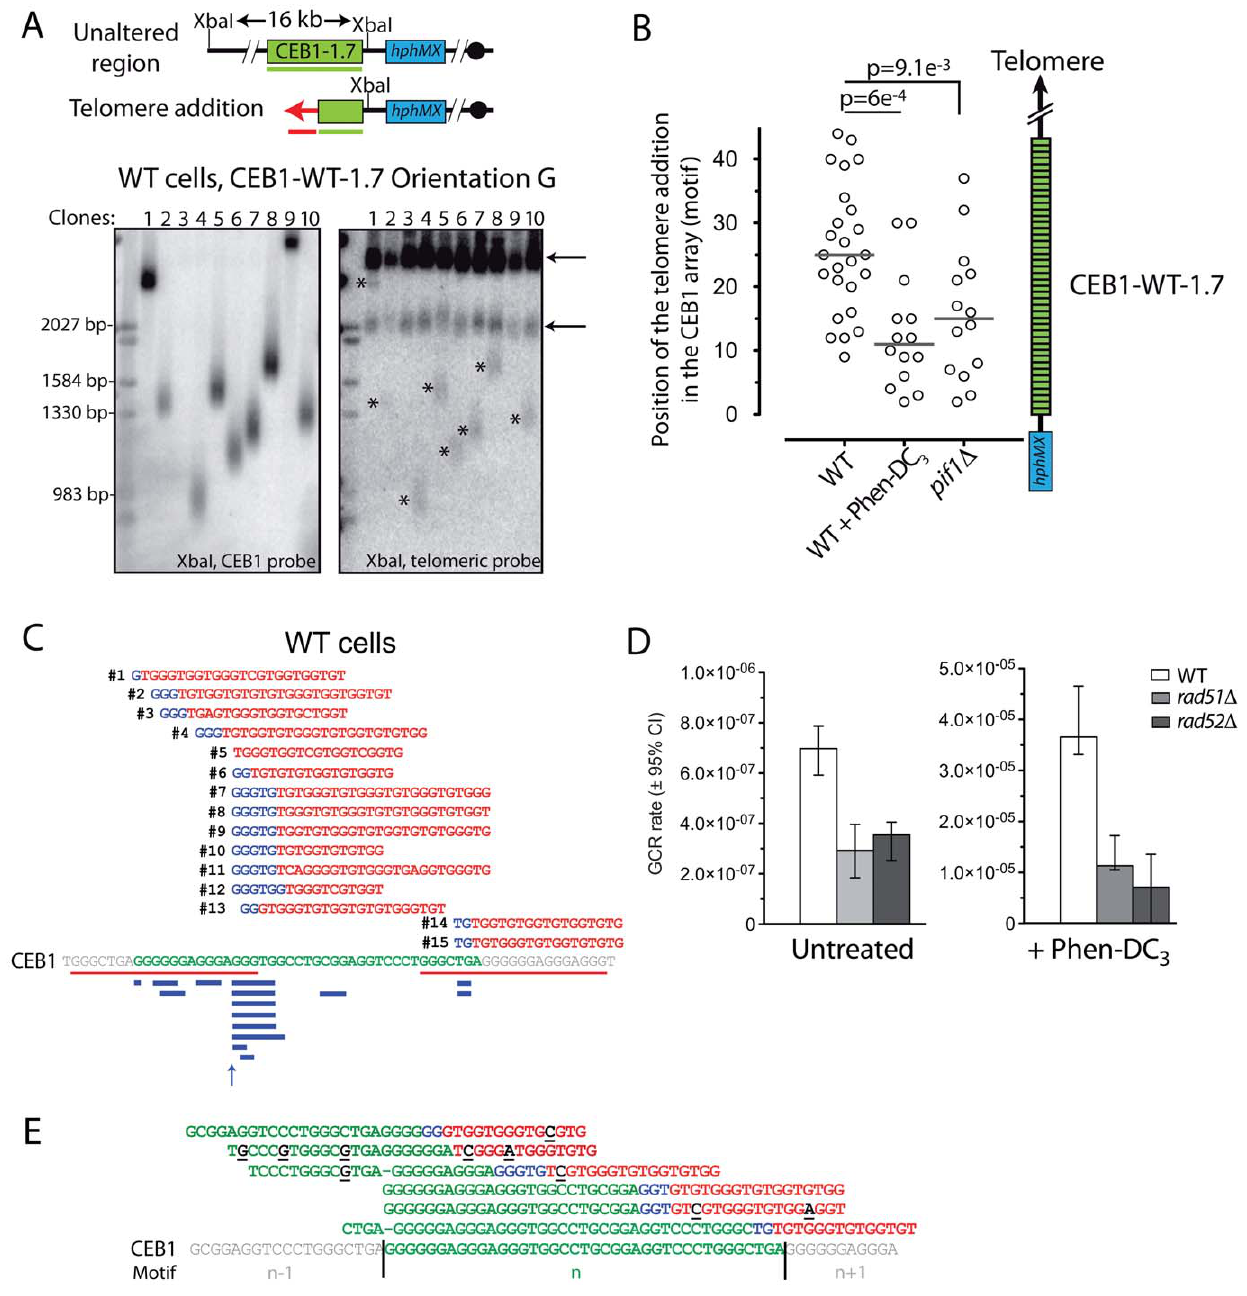
Figure 3. GCR are mainly telomere additions in CEB1. (A) The top panel schematically represents the genomic region surrounding CEB1 with the XbaI restriction site and the CEB1 (green) and TG 1–3 (red) probes used to study rearrangements of the region. The size of the unaltered region upon digestion is indicated. Upon telomere addition, digestion with XbaI is expected to produce a fragment that can be hybridized by both the CEB1 and the telomeric (TG 1–3 ) probe. The bottom panels show the rearrangements present in independent 5FOA/Can-resistant colonies obtained from WT cells bearing CEB1-WT-1.7 in the orientation G (ORT6542-6). Stars indicate smears hybridizing both the CEB1 and the telomeric probes (Orientation G lanes 1,2,4,5,6,7,8,10). Arrows indicate endogenous telomeres. Ambiguities remained for CEB1 smears co-migrating with endogenous telomeres (clone 9). One lane shows no CEB1 signal (clone 3). (B) Distribution of the telomere addition positions within CEB1-WT-1.7 estimated from the mean molecular weight determined by Southern blot (see Materials and Methods) in untreated and Phen-DC 3 -treated WT cells (ORT6542-6), and pif1 D cells (ORT6543-1). Grey bars show the median of the distributions. Distributions were compared using a non-parametric test (Mann-Whitney- Wilcoxon). (C) Analysis of the CEB1-telomere junctions in WT cells (ORT6542-6). Each CEB1-telomere junctions have been obtained from 15 independent 5FOA/Can-resistant colonies. The sequences are oriented 5 9 -3 9 . The template CEB1 motif is shown in green, and the flanking motifs (n 2 1 and n + 1) are shown in grey. The G-quadruplex forming motifs are underlined in red. Nucleotides shared by both the CEB1 and the telomeric sequences at the junction are in blue. The telomeric sequence is in red. The CEB1 sequence above the junctions is identical to the CEB1 reference, and is not shown for each molecule. A schematic representation of the length of shared nucleotides between the CEB1 and the telomeric sequences is shown in blue below the reference CEB1 motif. An arrow indicates the junction in which no nucleotide is shared. (D) GCR rates in WT (ORT6542-6), rad51 D (ORT7189), and rad52 D (ORT7310-2) cells bearing CEB1-WT-1.7 upon treatment (right) or not (left) with Phen-DC 3 at 10 m M. The scale is linear.